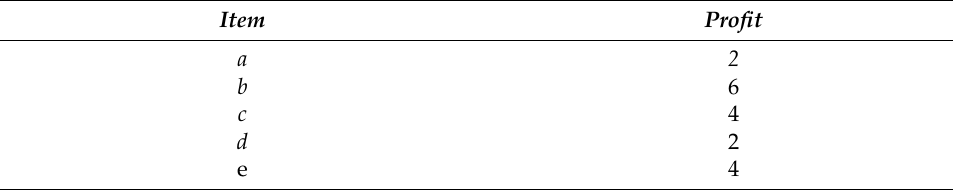
Table 2. Unit Profit values of